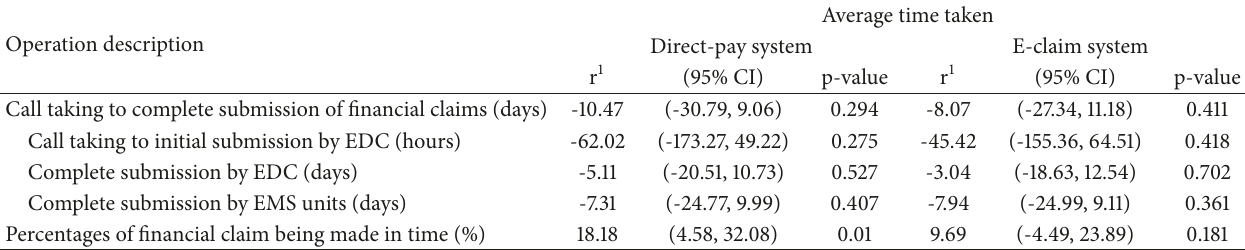
Table 3: Time flow of claim data under direct-pay and e-claim systems adjusted by project-year of